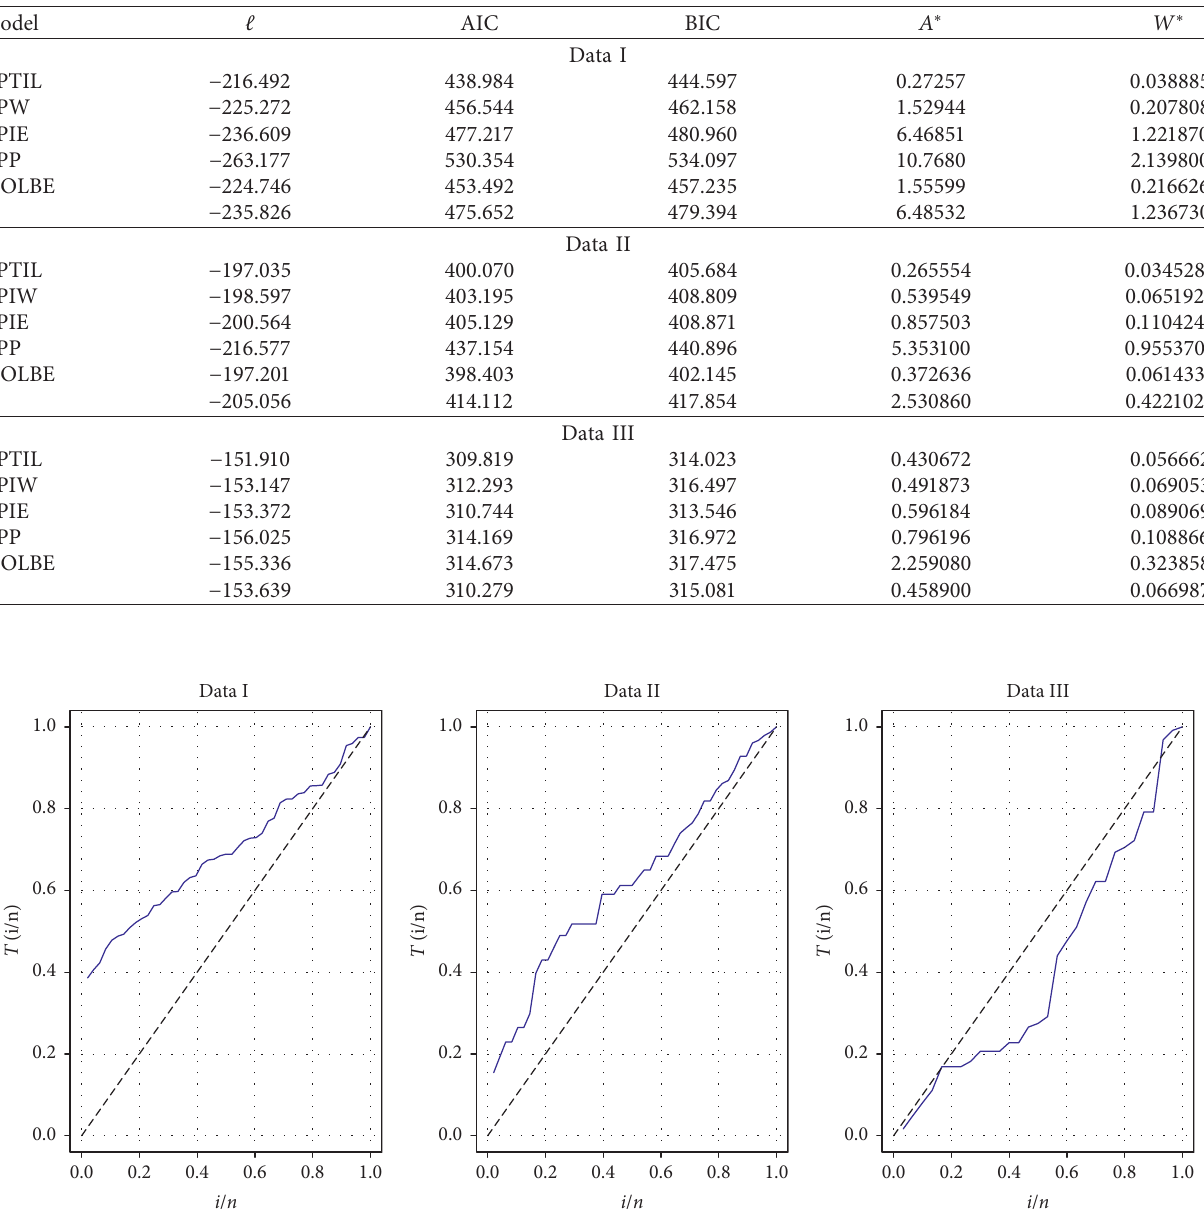
Table 7: Goodness of fit measures for the data sets.